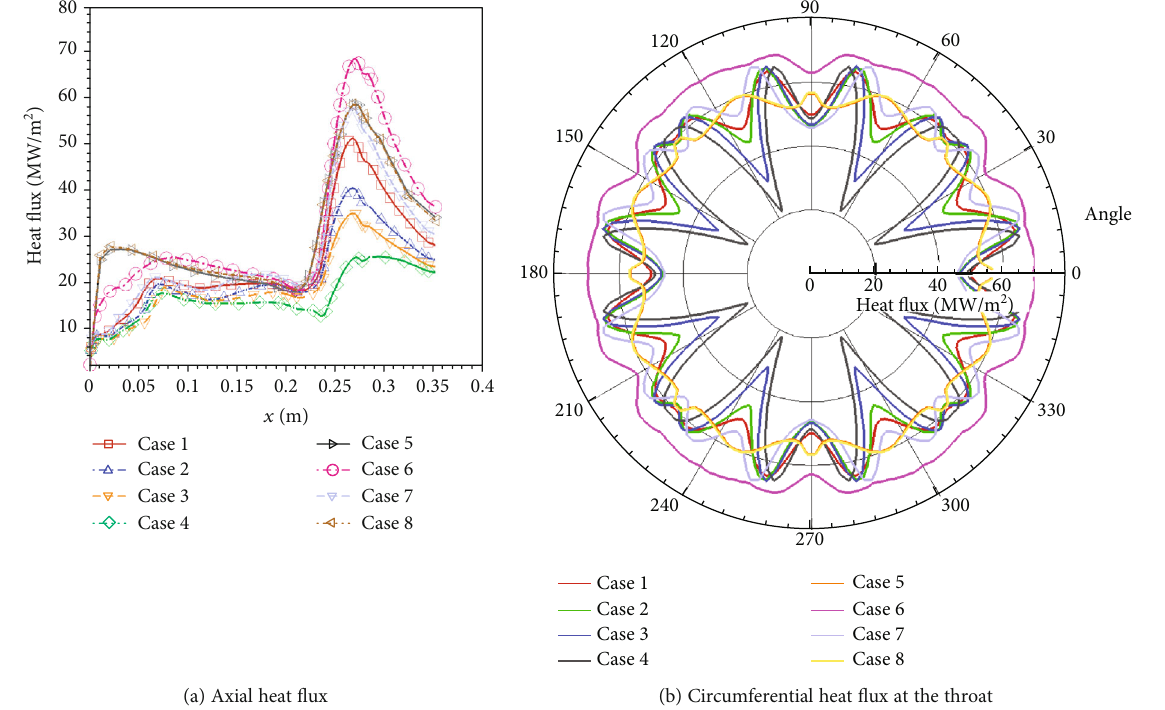
Figure 6: The numerical results of heat fl ux analysis.